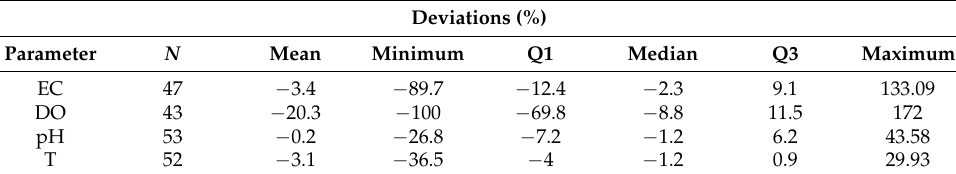
Table 5. Analysis of percentage deviations of water quality parameters recorded by the automatic stations from in situ measurements carried out with a portable instrument during site visits.